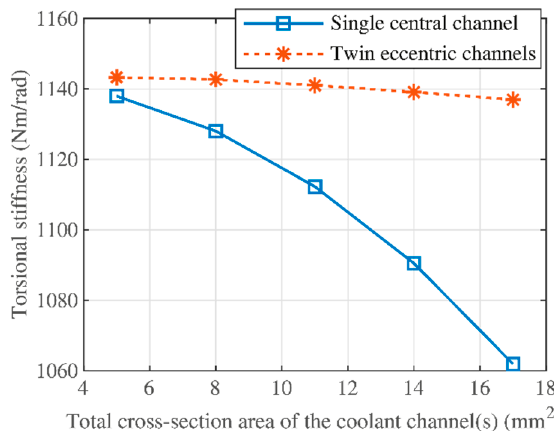
Figure 9. Torsional stiffness versus total cross-section area of the coolant channels.